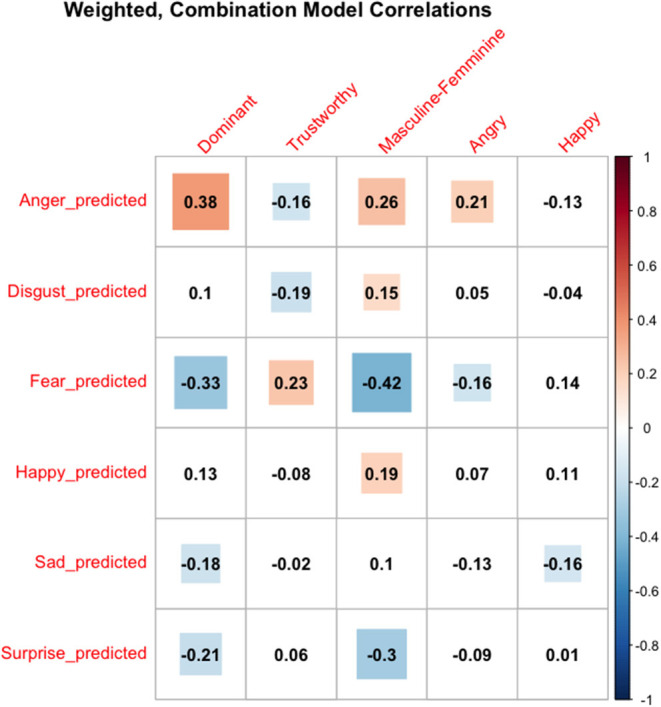
Correlations between weighted combination model predictions and human impressions. Machine-derived output is on the Y-axis, whereas human ratings are on the X-axis. Colored cells are significant. Hot colors are significant positive correlations and cool colors are significant negative correlations.